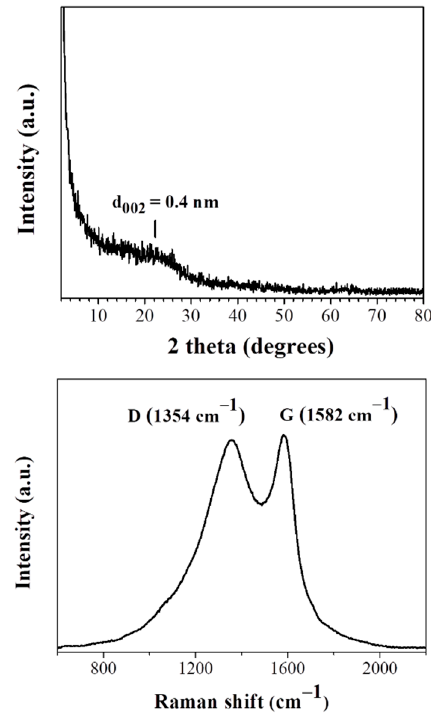
Figure 3. XRD pattern (top) and Raman spectrum (bottom) of the carbon sample.